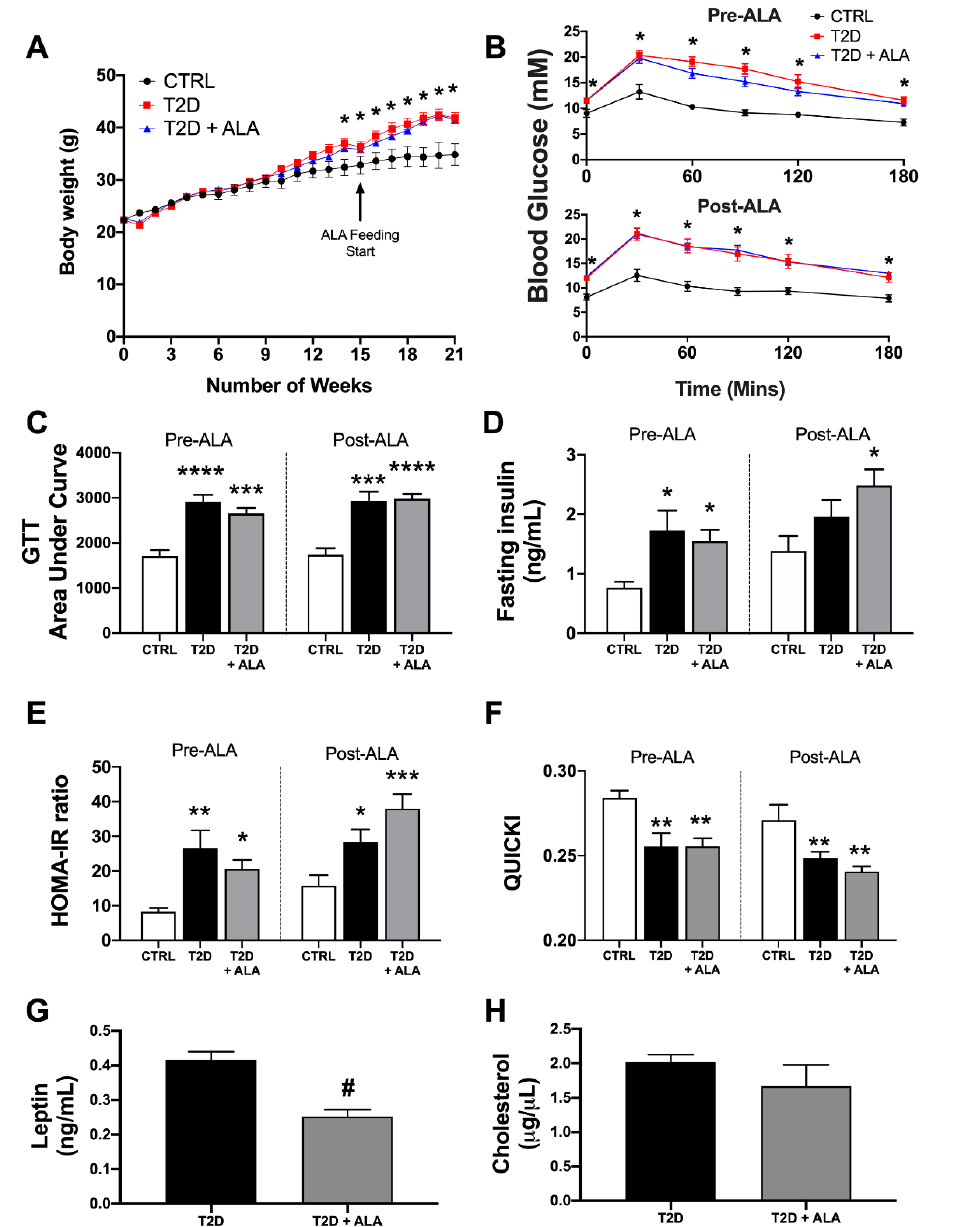
Figure 1. Metabolic phenotype in T2D mice ± dietary α -linolenic acid (ALA) supplementation. Data are shown for ( A ) body weight change over time (control [CTRL], n = 8; T2D, n = 21; T2D + ALA, n = 22); ( B ) glucose tolerance test (GTT) curve (CTRL, n = 8; T2D, n = 11; T2D + ALA, n = 12); ( C ) GTT area under curve (AUC) (CTRL, n = 8; T2D, n = 11; T2D + ALA, n = 12); ( D ) fasting serum insulin (CTRL, n = 8; T2D, n = 9; T2D + ALA, n = 10); ( E ) insulin resistance, based on homeostatic model assessment of insulin resistance (HOMA-IR) (CTRL, n = 8; T2D, n = 9; T2D + ALA, n = 10); ( F ) insulin sensitivity, based on quantitative insulin sensitivity check index (QUICKI) (CTRL, n = 8; T2D, n = 9; T2D + ALA, n = 10); ( G ) serum leptin ( n = 8/group); and ( H ) total serum cholesterol ( n = 7/group). Data in panels C – F were acquired at 14 weeks of western diet (1 week pre-ALA) and after an additional 6 weeks of continued feeding or dietary intervention (5 weeks post-ALA). Results presented as means±SEM. *, p < 0.05 vs. CTRL; **, p < 0.01 vs. CTRL; ***, p < 0.001 vs. CTRL; ****, p < 0.0001 vs. CTRL; and #, p < 0.001 vs. T2D.